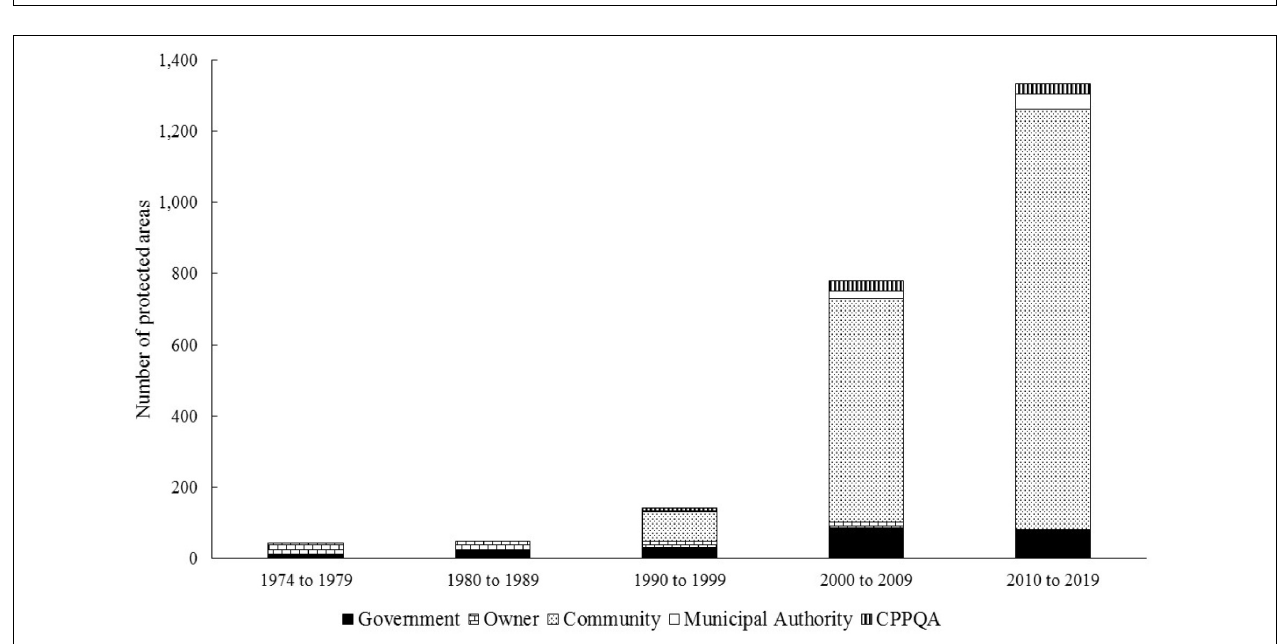
FIGURE 5 | Number of chelonian nesting beaches protected by different management systems in the Amazonas state and the northwestern section of the Pará state, Brazil, between 1974 and 2019.